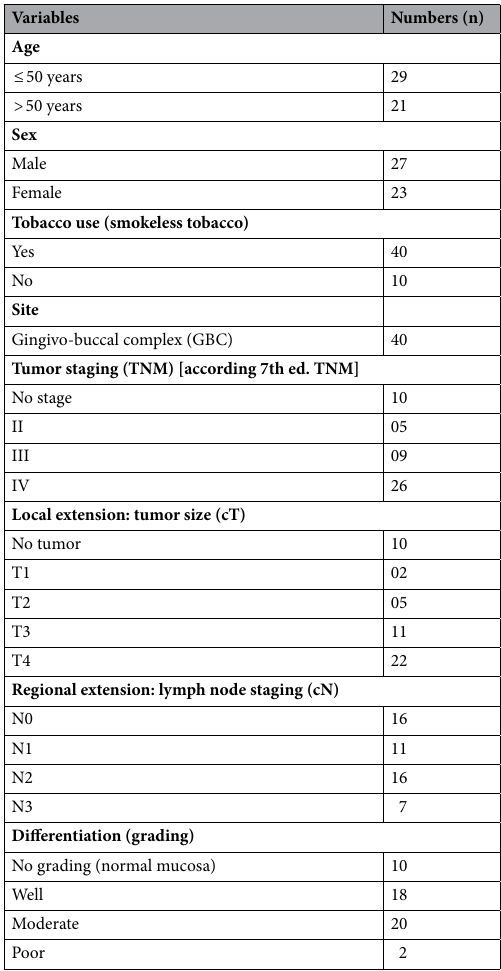
metastasis. (Table 7). In the graphical representation of the differential expression related to the genes, TNC showed the highest fold change difference when moderately differentiated OSCC samples were compared to poorly differentiated cases. POSTN too had enumerable fold change difference when in comparison to different grades (Fig. 3). When p-values were calculated, TNC had a highly significant value in well vs poorly differenti- ated cases (p < 0.0001). Further, POSTN also showed a significant difference when well-differentiated cases were compared to poorly-differentiated cases (Table 8). Immunohistochemistry.